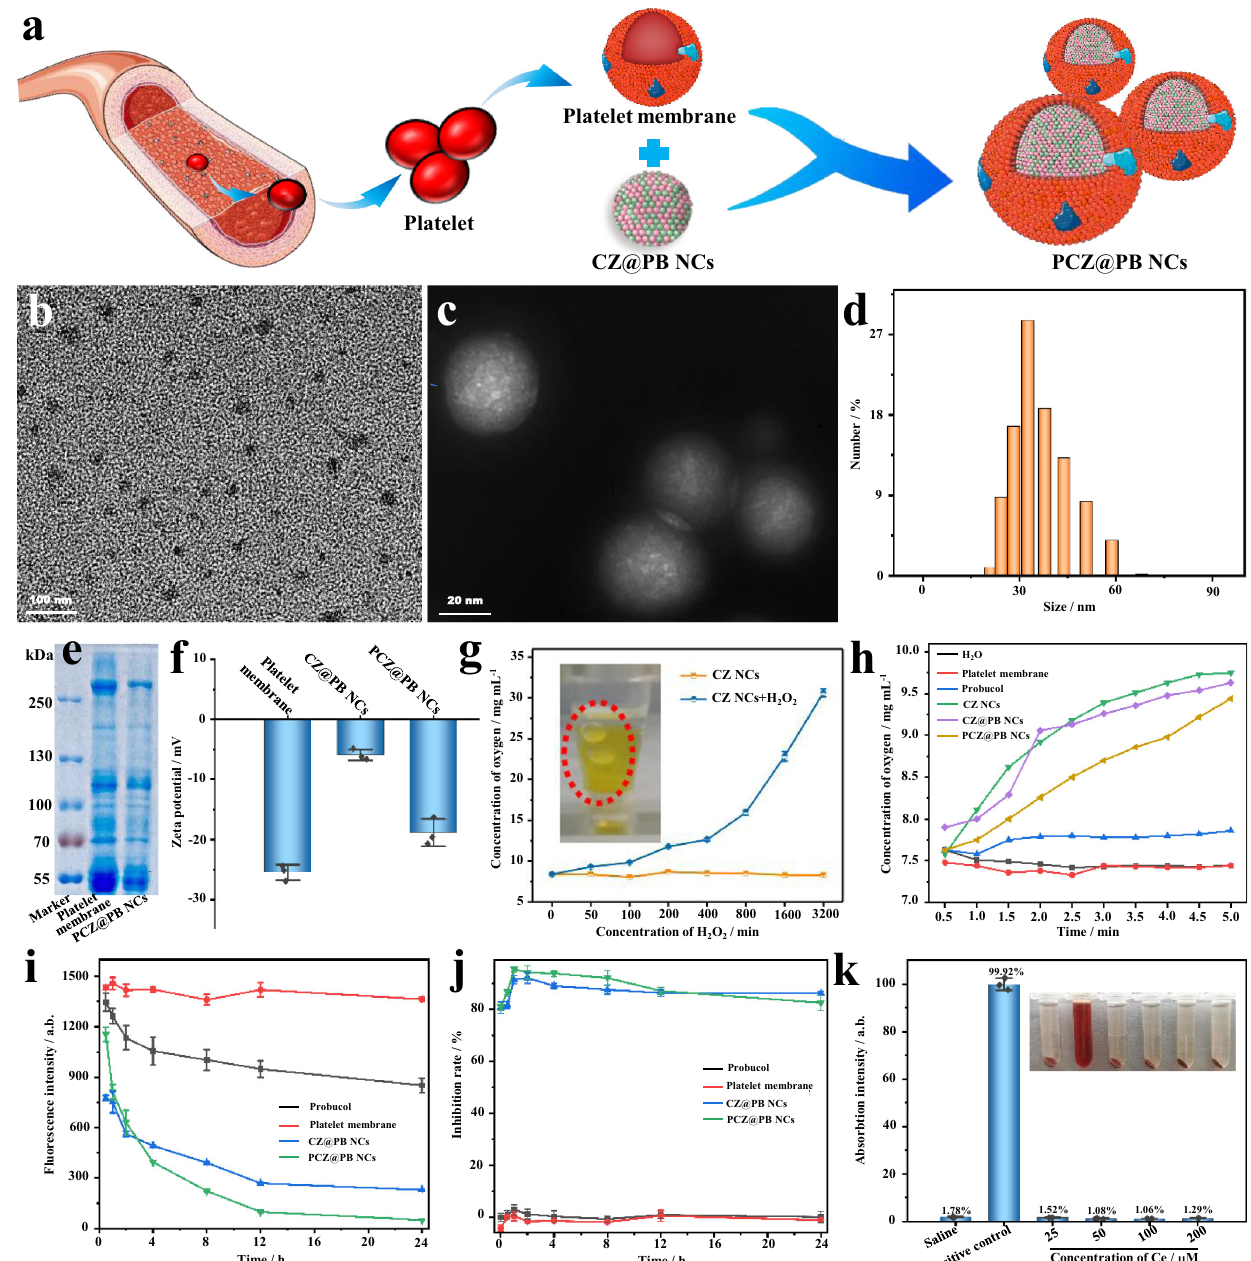
Fig. 3 | Characterization of the biomimetic nanodrugs PCZ@PB NCs, and ver- i fi cationoftheirmultienzymeactivity.a Schematicillustratingthepreparationof PCZ@PB NCs with a platelet membrane coating on CZ@PB NCs. b TEM image of PCZ@PBNCs. c TEMimageofPCZ@PBNCsnegativelystainedwithuranylacetate. d Sizedistribution. e RepresentativeproteinbandsstainedwithCoomassiebrilliant blue. f Zetapotential. g CharacterizationoftheabilityofCZNCstocatalyzeoxygen production from different concentrations of hydrogen peroxide (H 2 O 2 ). h Determination of different components catalyzing H 2 O 2 (1mM) into oxygen within 5min. i Staining with the fl uorescent probe 2 ’ ,7 ’ -dichloro fl uorescein-diace- tate(DCFH-DA)tocharacterizetheconcentrationofH 2 O 2 inthesolutionover24h.